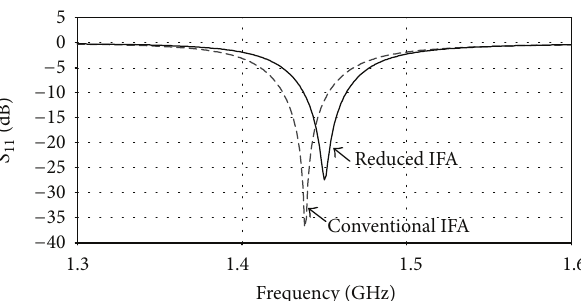
Figure 10: Comparison of the 𝑆 11 parameter of the reduced and conventional PIFA.